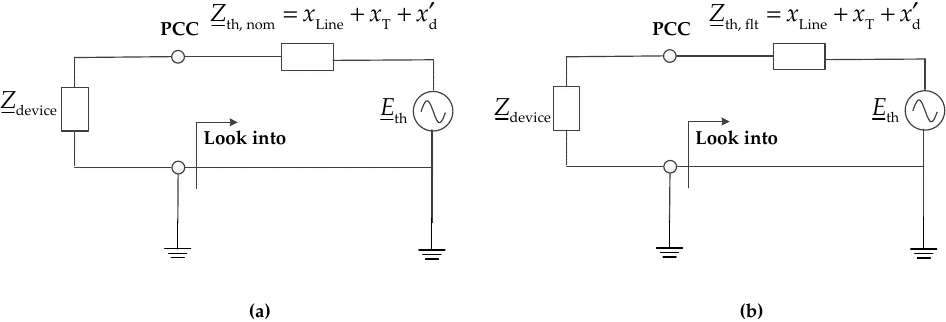
Figure 10. Thevenin equivalent circuit of the system when STATCOM adopts the constant reactive power control and the constant active power control: ( a ) STATCOM is under the normal state; ( b ) STATCOM is under the fault state.